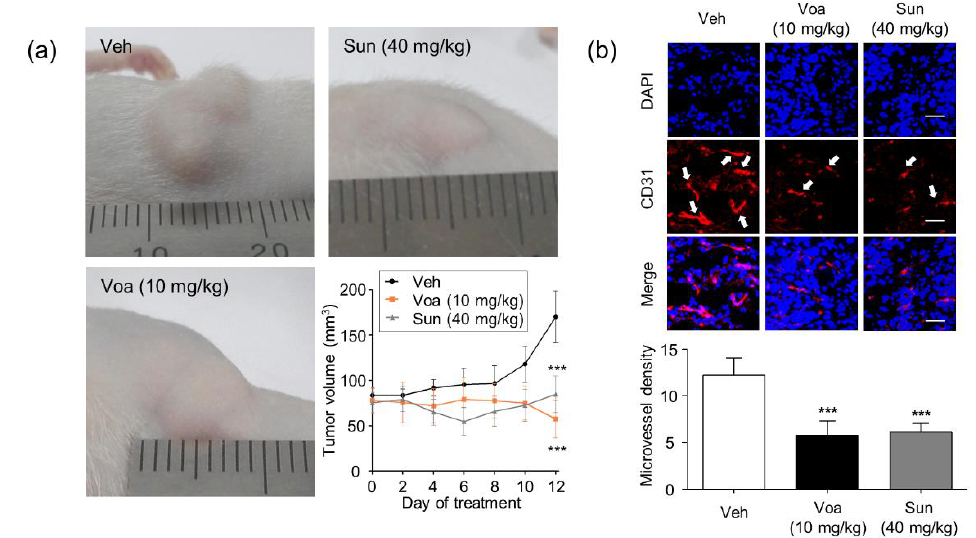
Figure 4. Voacangine inhibits xenograft tumor growth and angiogenesis in vivo. ( a ) Representative images of U87MG tumor xenograft on 12 days. Athymic nude mice bearing glioblastoma tumors consisting of U87MG glioblastoma cells were treated with vehicle, voacangine (10 mg / kg, intraperitoneal treatment), or sunitinib (40 mg / kg, oral treatment). *** p < 0.001 versus vehicle treatment. ( b ) E ff ect of voacangine or sunitinib treatment on the expression levels of the vascular marker, CD31 in tumor tissues. All images shown are representative of three independent experiments. White arrows indicate CD31 expression. Original magnification of fluorescence images for CD31 staining: 400 × g . Scale bar, 50 µ m. Microvessel density was measured by counting the number of CD31-positive structures in three random fields. Each value represents the mean ± S.D. from three independent experiments. *** p < 0.001 versus vehicle treatment. Veh, vehicle-treated; Voa, voacangine-treated; Sun,